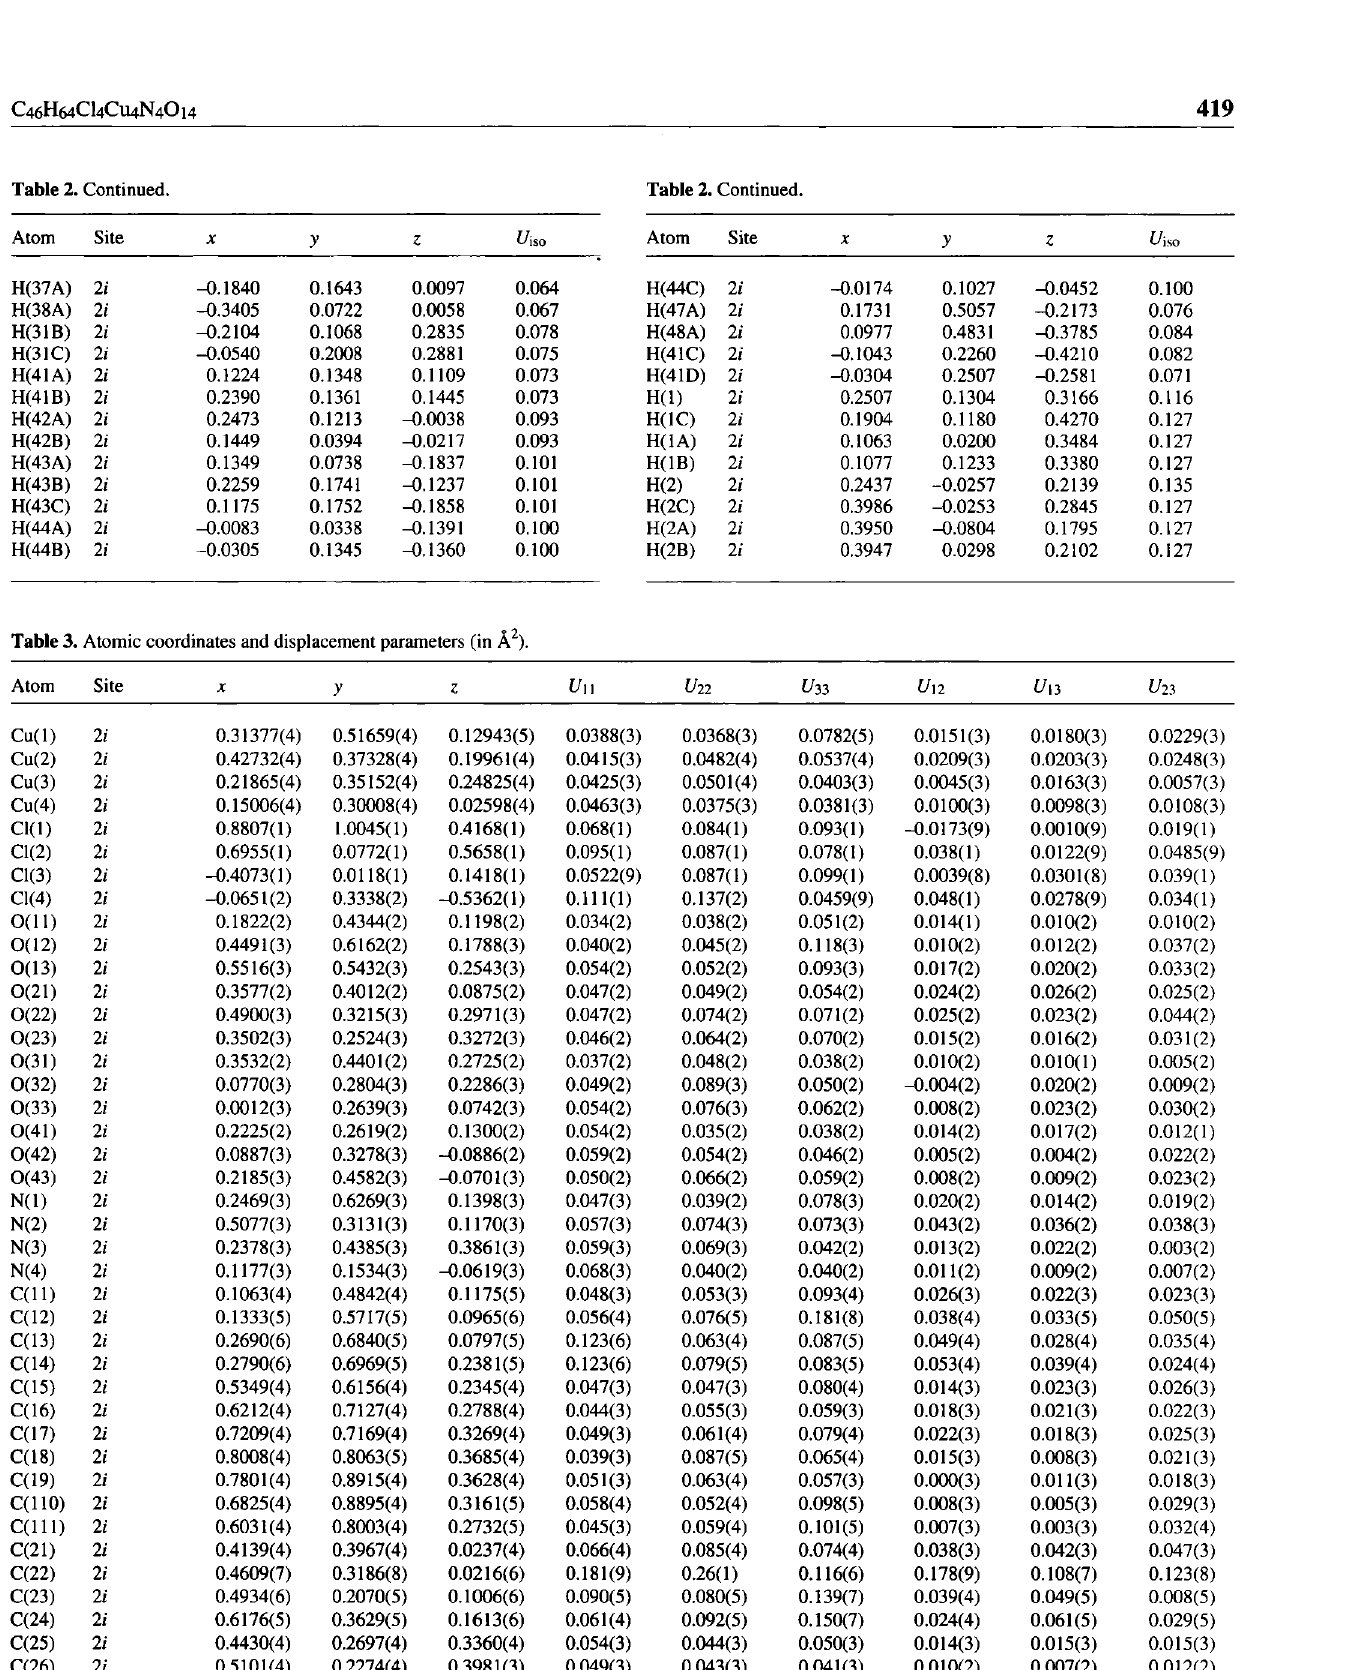
Table 3. Atomic coordinates and displacement parameters (in Ä 2